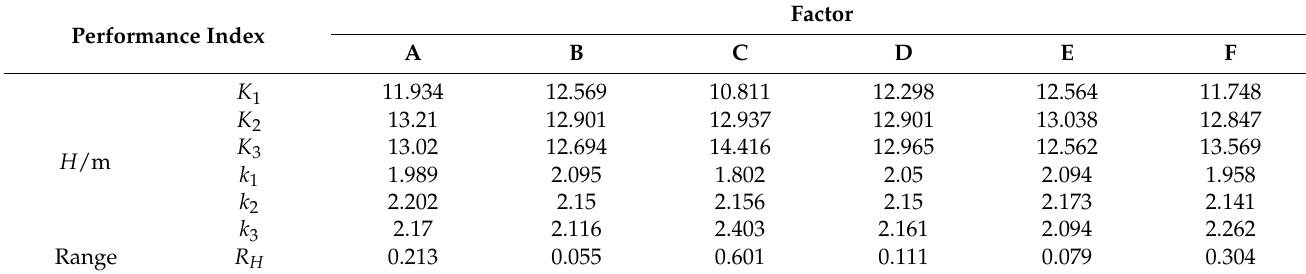
Table 3. Range analysis of pump